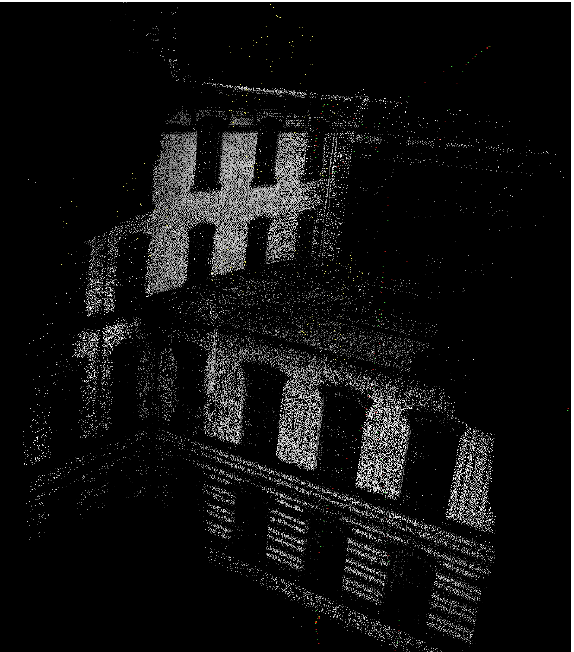
Figure 2: Sparse 3D reconstruction from flight images. Note that for the reconstruction of the facade and roof a MAV is necessary, as UAVs or ground-based cameras cannot reach these viewpoints.